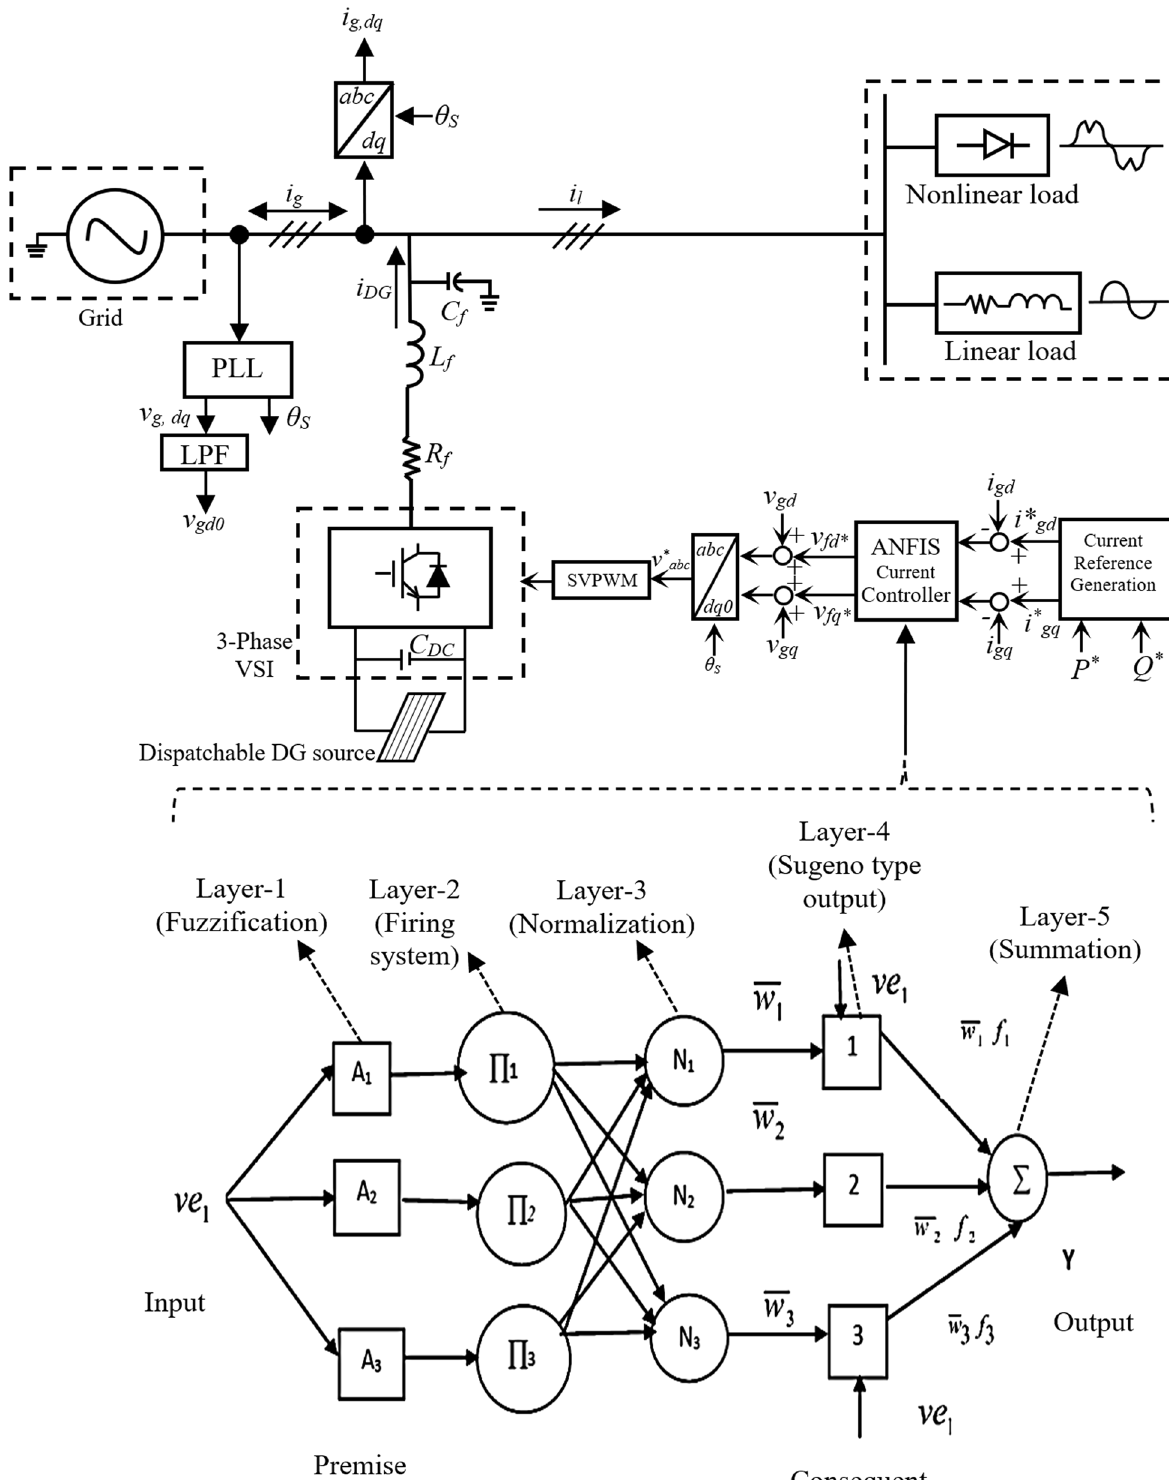
Fig. 7 ANFIS optimized PI controller for DG